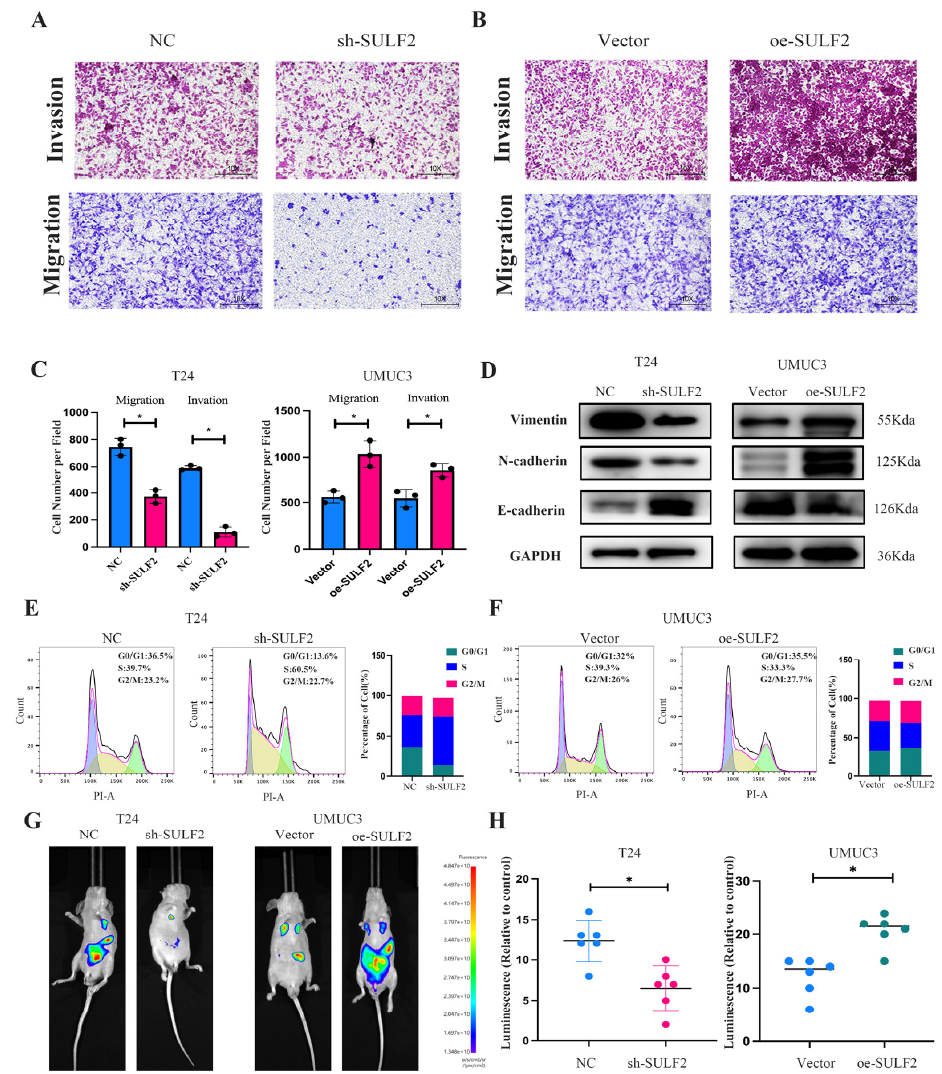
Figure 4. SULF2 affects metastasis of BCa cells. ( A – C ) Transwell assay was used to examine the migratory and invasive capacities of BCa cells after knockdown and overexpression of SULF2. Scale bar = 100/50 µ m. ( D ) The expression of EMT-associated markers was analyzed by western blot after knockdown and overexpression of SULF2. ( E , F ) Flow cytometric detection of the effect of SULF2 on the cell cycle. ( G , H ) Representative images of IVIS after tail vein injection of knockdown or overexpressing SULF2 cells. Data are represented as mean ± SD of three experiments. * p < 0.05.